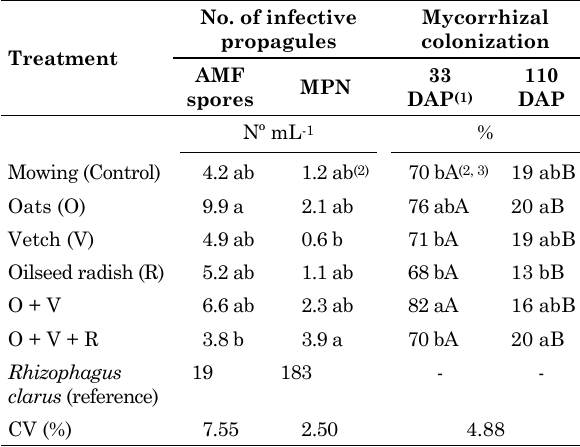
table 2. number of spores and infective propagules of mycorrhizal fungi and mycorrhizal colonization of cassava after cultivation of cover crops